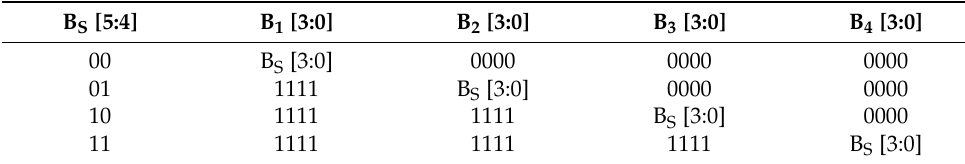
( b ) Figure 11. Sub clock generation for 4-channel sub-ADCs. ( a ) A 1.25 GHz 4-phase clock generator. ( b ) Timing diagram. In this design, the non-overlap between the two clocks was realized using the DM logic shown in Figure 12. The DM logic guarantees that the rising edge of Φ (cid:2897) always starts after the gate delay of two inverters rather than the falling edge of Φ (cid:2903) . D